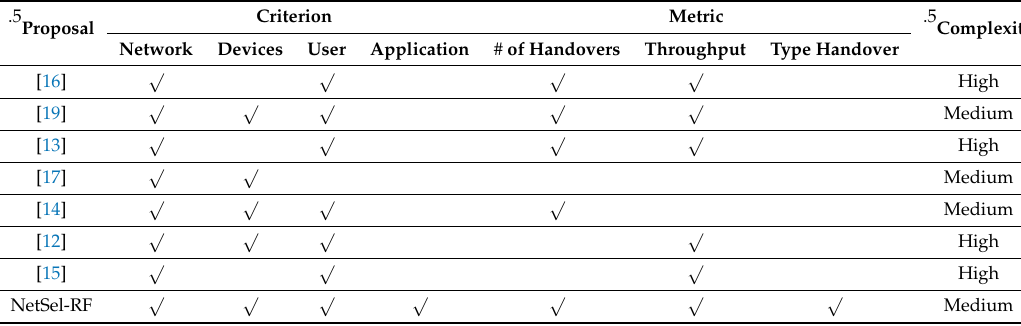
Table 1. Multi-criteria based related